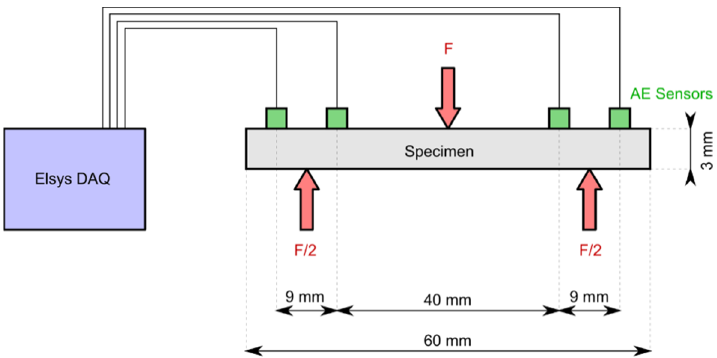
Figure 8. Overview of the experimental setup for static three-point bending tests on miniature beam specimens.